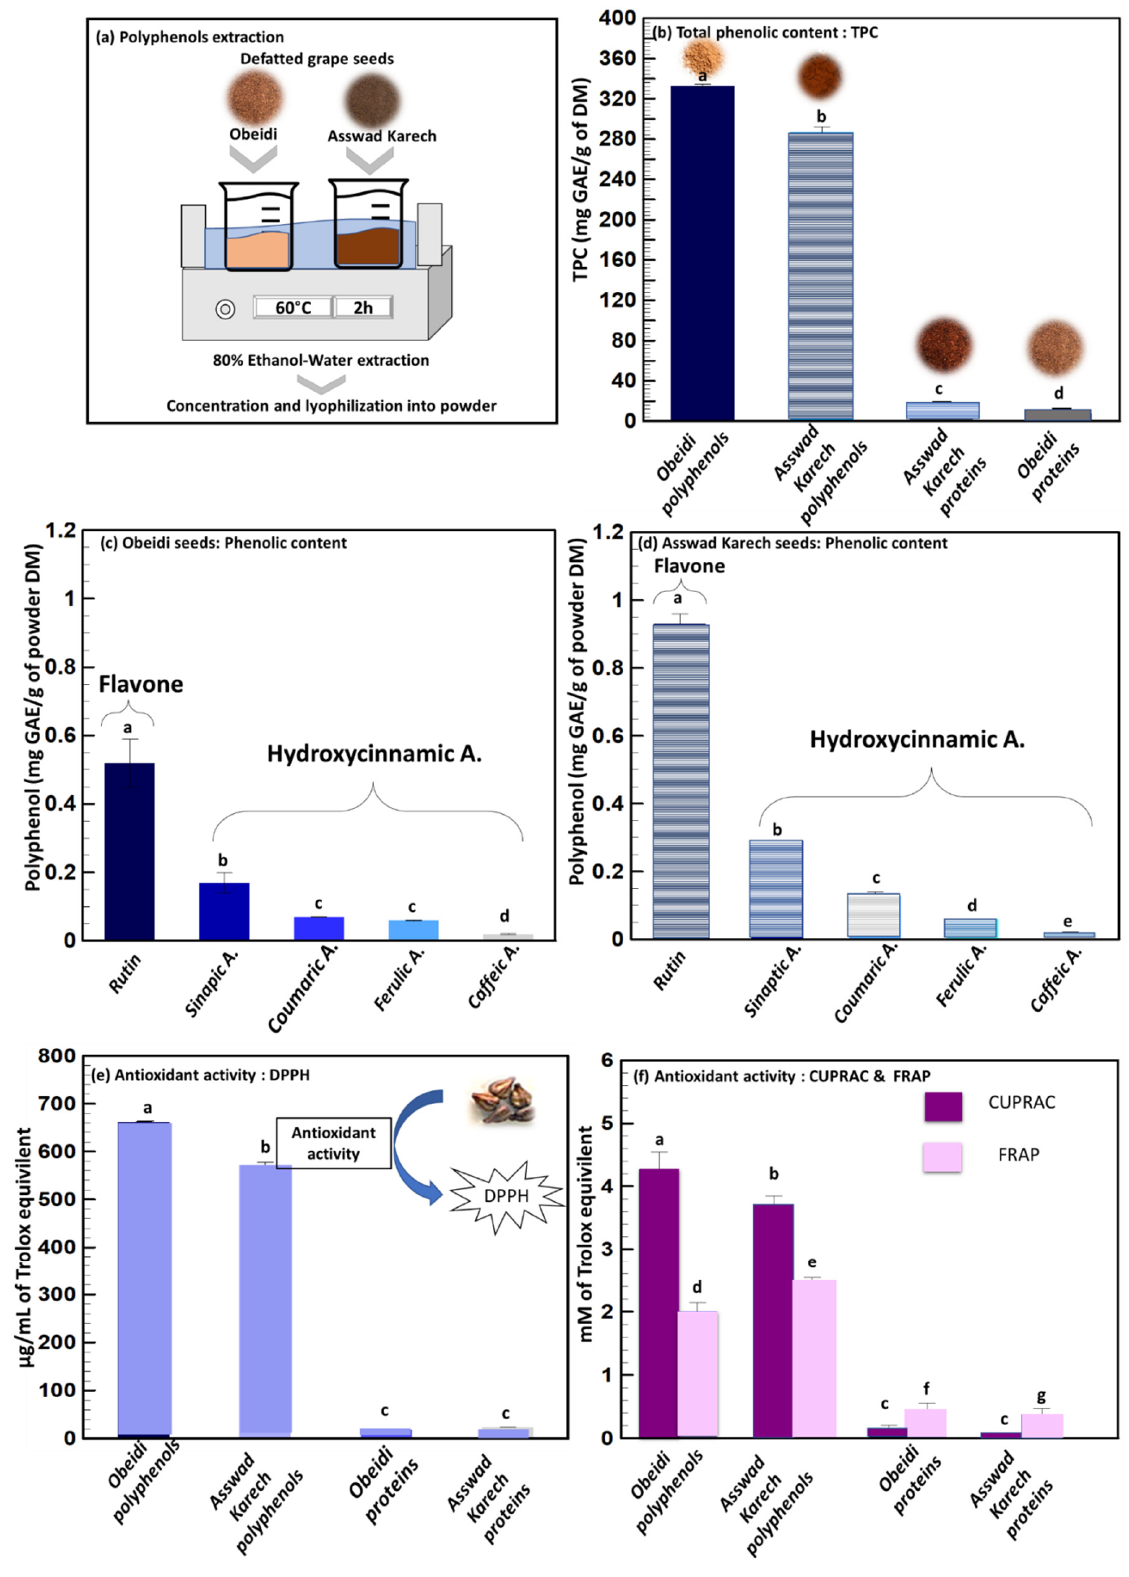
Figure 3. Polyphenol’s extraction. ( a ) Solid–liquid extraction, ( b ) total phenolic content of polyphenol and protein fractions, ( c , d ) identification and quantification of phenolic compounds from Obeidi and Asswad Karech polyphenol’s fractions, respectively, and antioxidant activity by ( e ) DPPH assay and ( f ) FRAP and CUPRAC assays of polyphenol and protein fractions. Means sharing the same letter are not significantly different from each other (with p > 0.05).